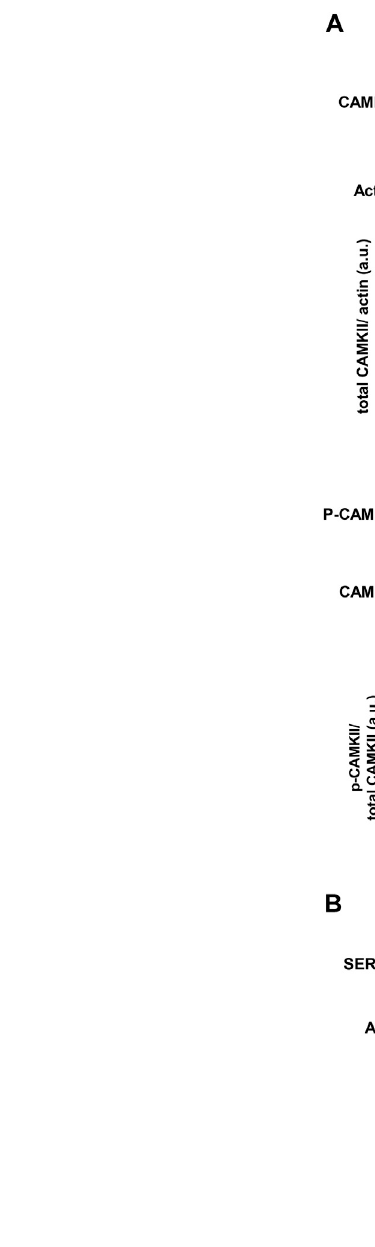
FIGURE 9 The effects of R92Q-cTnT on Calcium Signaling — CAMKII and SERCA2a abundance. (A) Western blot analysis of CAMKII abundance and phosphorylationofCAMKIIand (B) SERCA2aabundanceinNTGandTGhearts.NTG,non-transgenic;